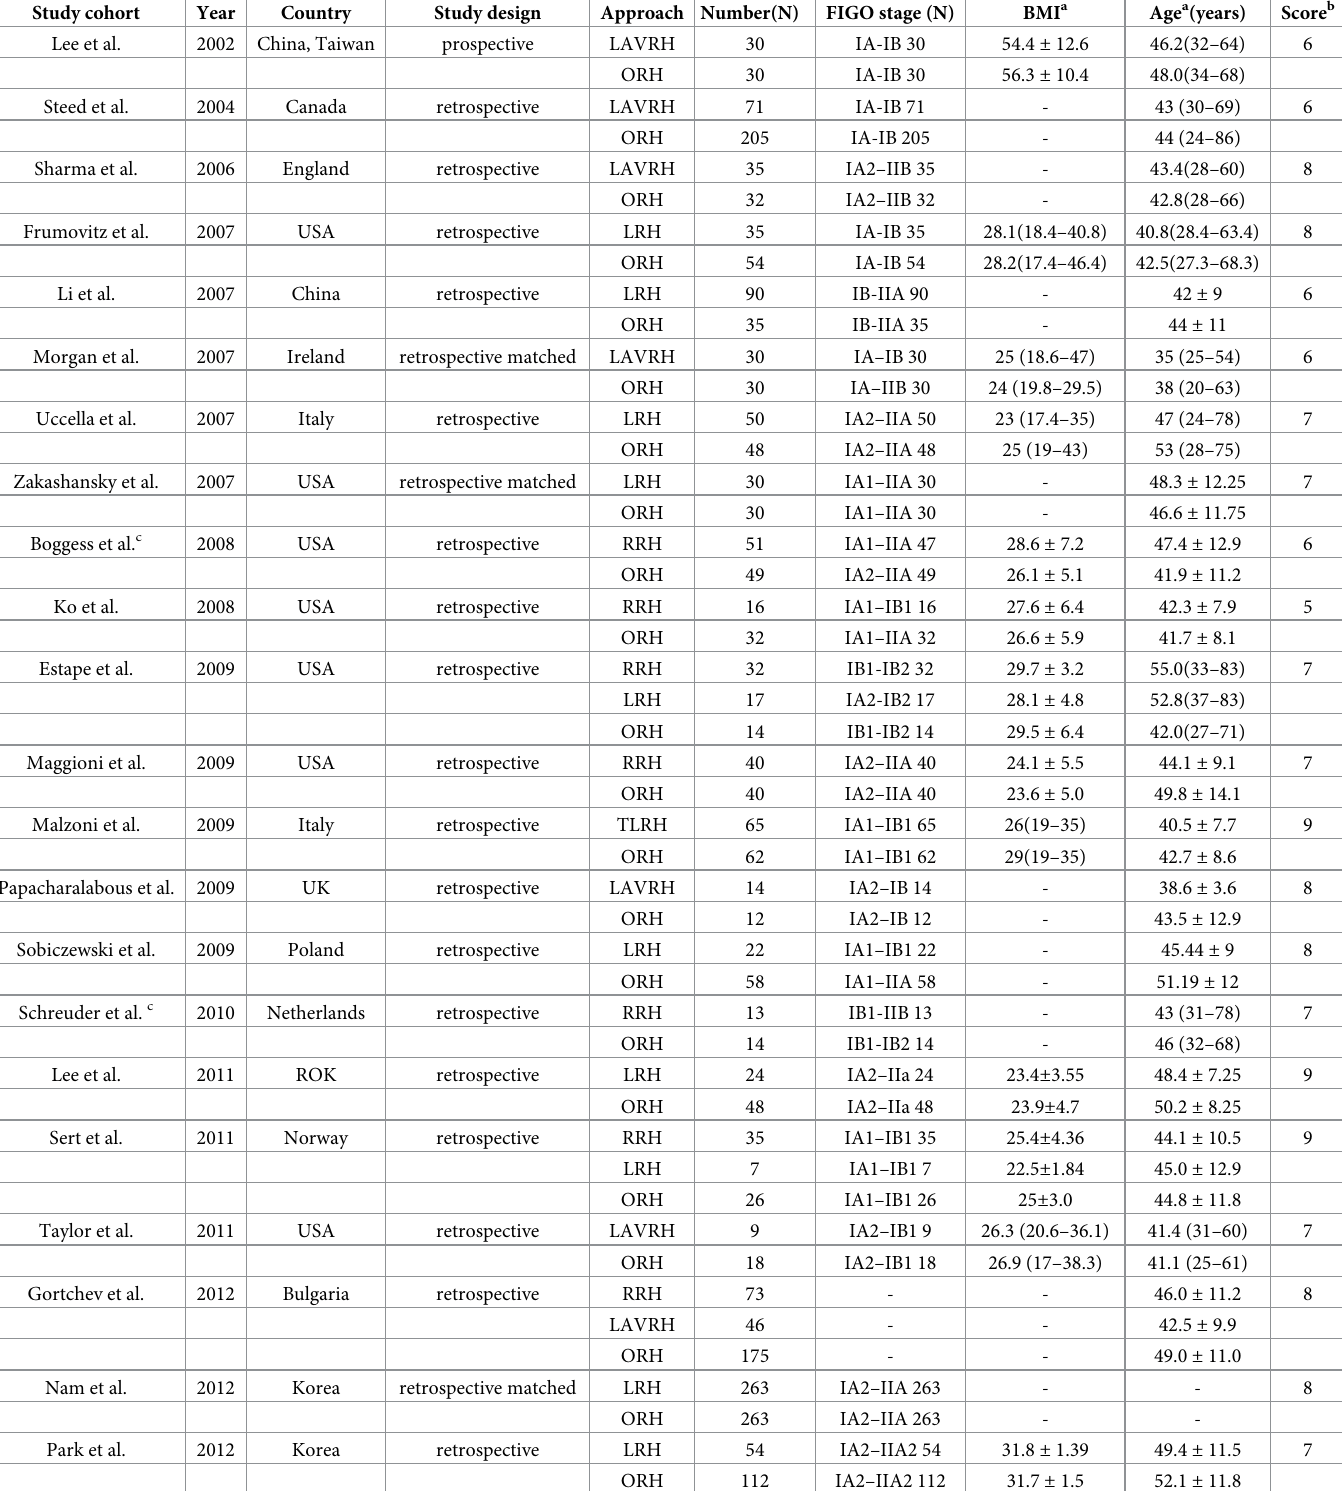
Table 1. Characteristics of the 40 studies included in the